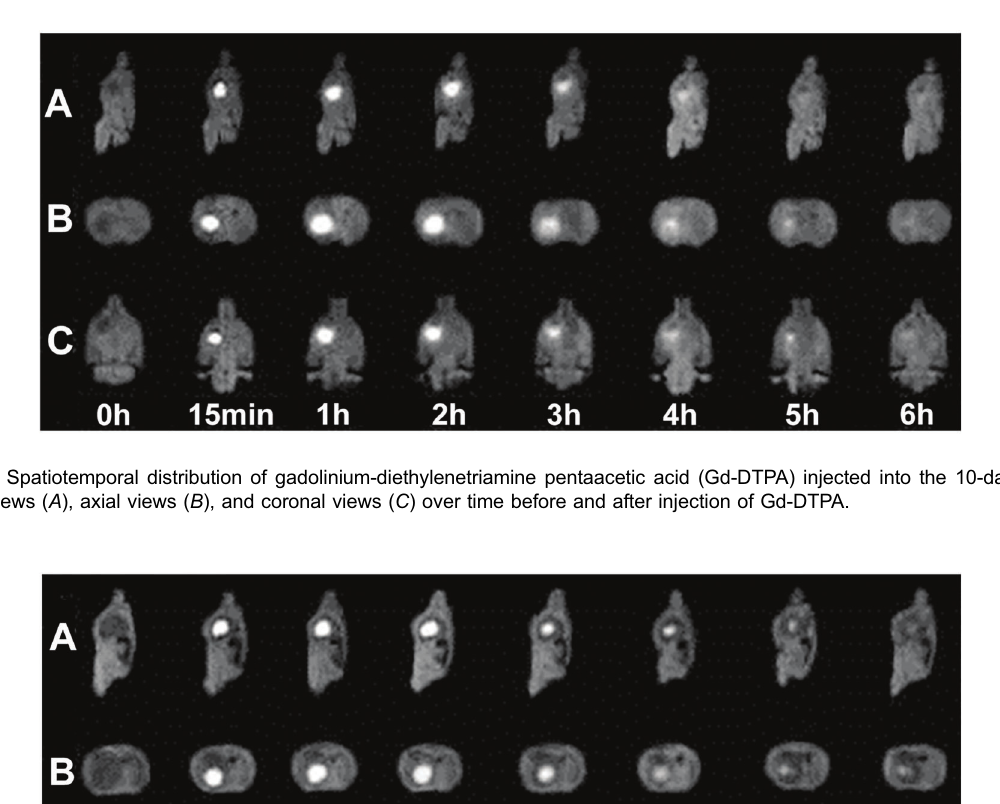
Braz J Med Biol Res | doi: